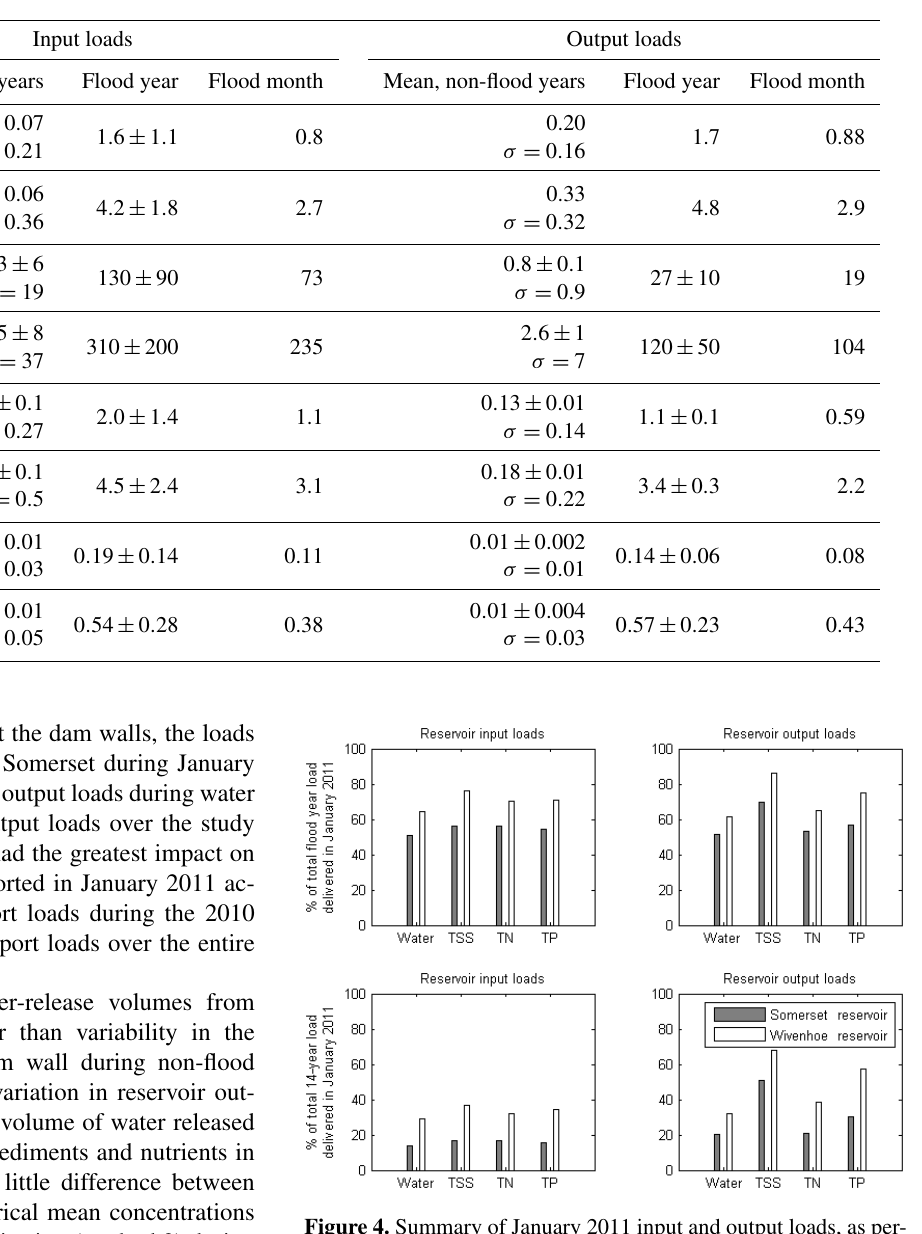
Table 1. Input and output loads of water, TSS, TN and TP for the Somerset and Wivenhoe reservoirs from June 1997 to July 2011 ± uncertainty; σ is the standard deviation of annual values over non-flood years. Water years are defined from July to June. Water year 2010 is the flood year, other years are non-flood years. January 2011 is the flood month. S: Somerset reservoir, W: Wivenhoe reservoir.